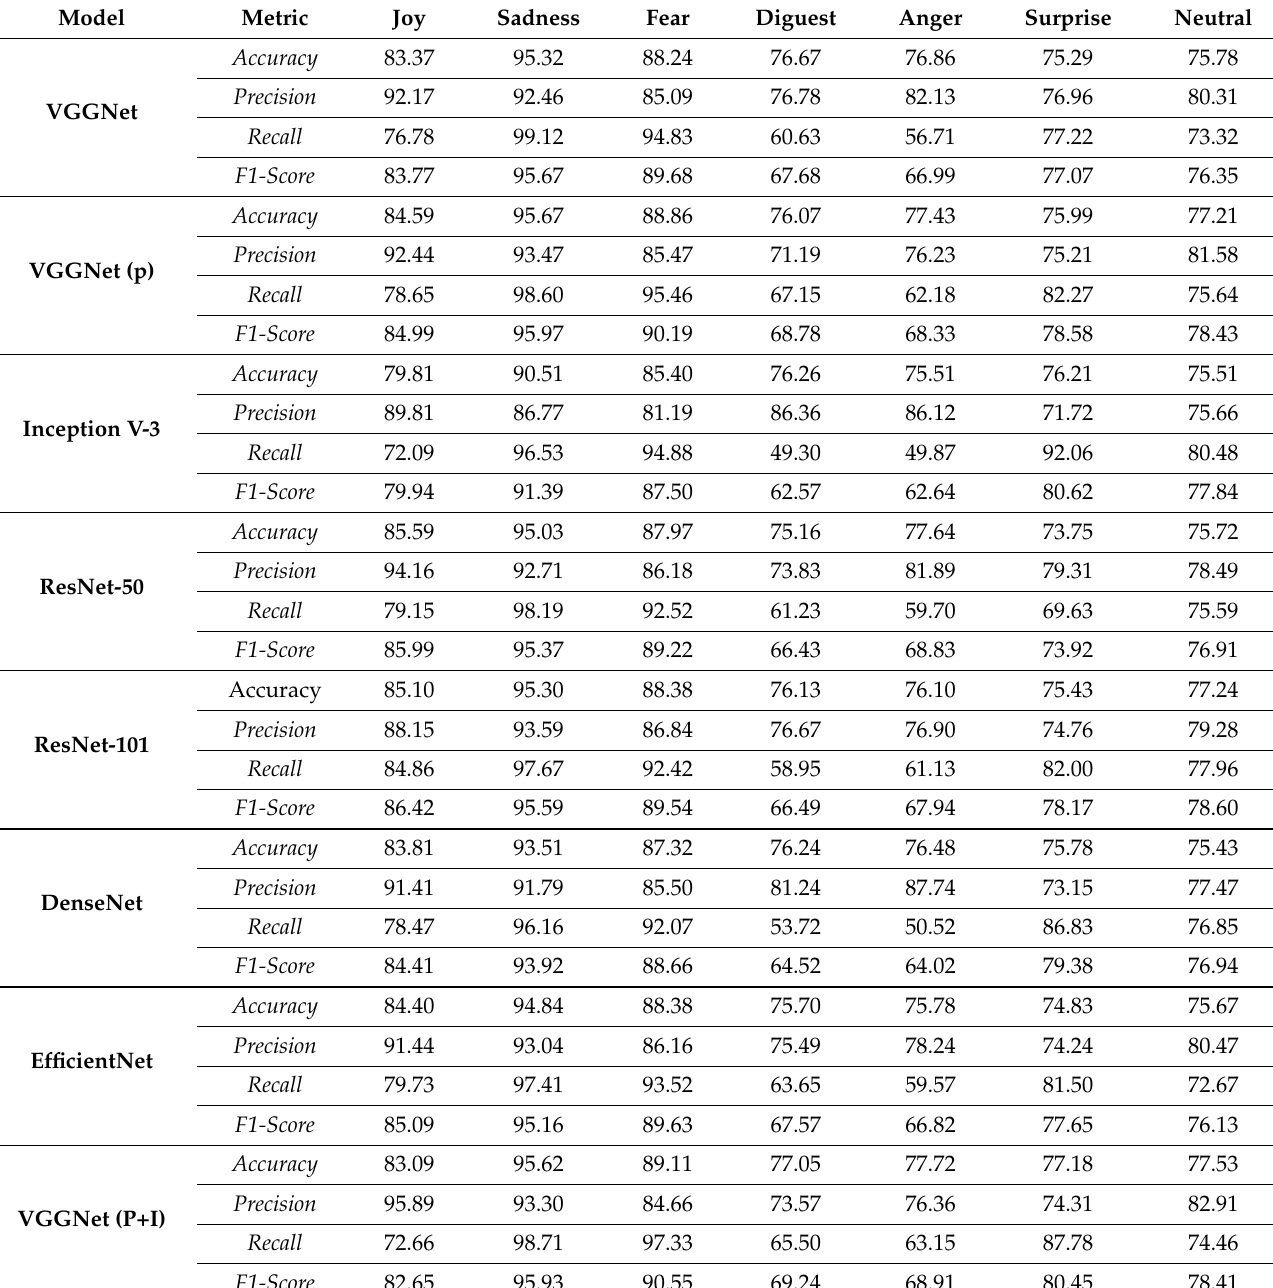
Table 10. Experimental results of the proposed visual sentiment analyzer on task 2 in terms of accuracy, precision, recall, and F1-score per class. P represents the version of the model pre-trained on the Places dataset while the rest are pre-trained on the ImageNet